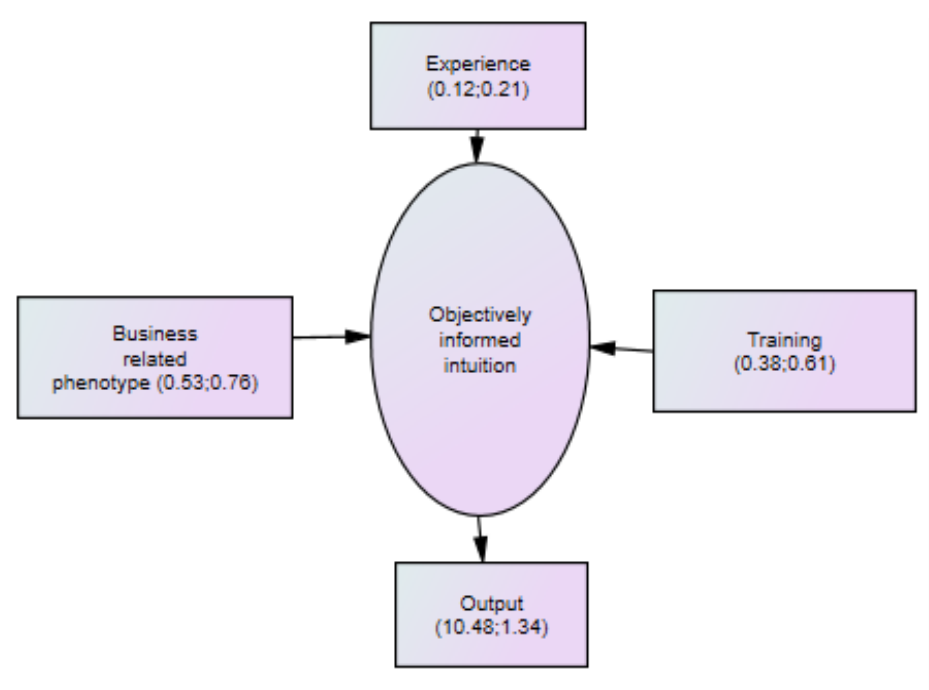
Figure 2. A simplified version of the SEM model showing the main results from the analysis. The model solution coefficients are shown in the brackets the first being for the objective ‘surplus cash’ weighted by the objective factors, and the second for ‘physical productivity’ similarly weighted by the objective factors. Each coefficient represents the parameter of the arrow representing the relationship between the input variable and the output (either weighted cash or physical productivity). The third relationship using the asset based objective is not shown being less important. The goodness of fit/reliabilty for the first objective (the others are similar) is given by CFI of 0.9, the NFI of 0.9, the RMSEA of 0.1 and the Hoelter of 148. They relate to the vary large sample of 1940).